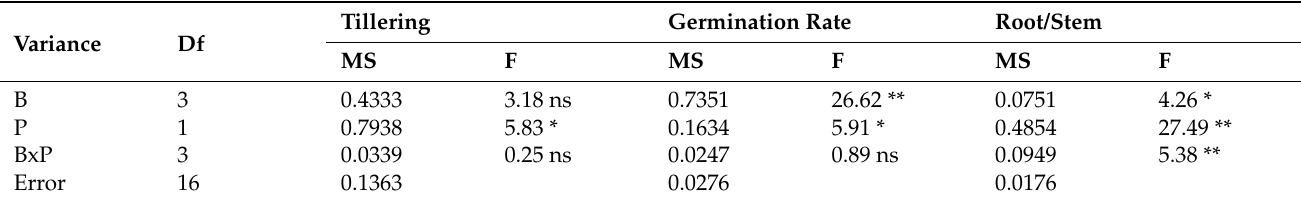
Table 4. Variance analysis table for the effects of biochar (B) and PGPR (P) applications on tillering, germination rate and root–stem ratio of Siyez wheat.